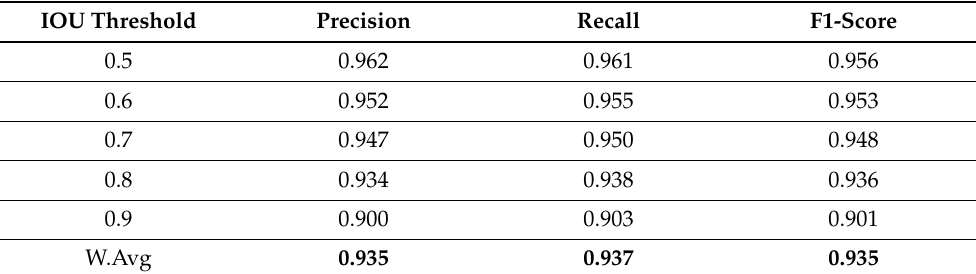
Table 4. HybridTabNet results on the mixed (Chinese + English) Marmot dataset. W.Avg denotes weighted-average of the respective measure on the IoU threshold.